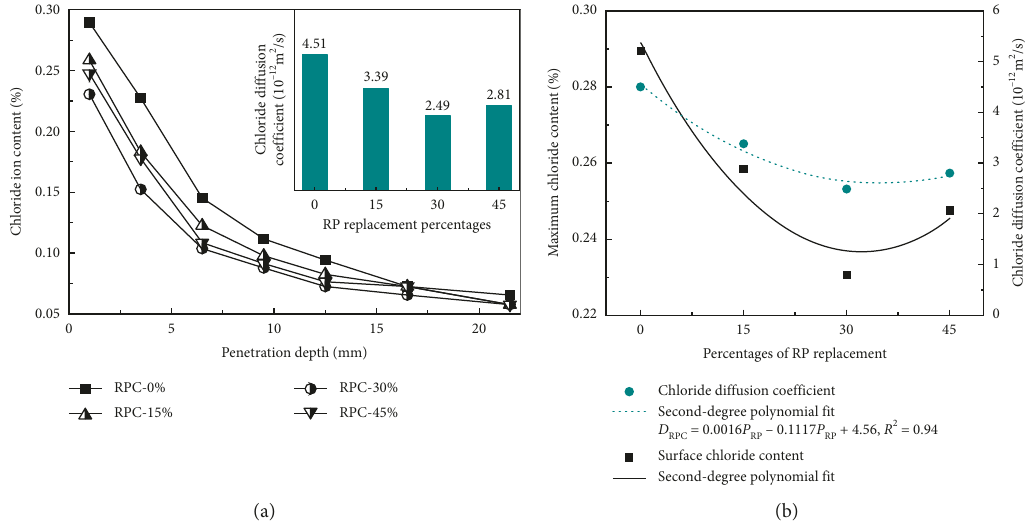
Figure 6: The chloride diffusivity of RPC without preloading damage. (a) The chloride content curves of RPC. (b) The correlation between the chloride diffusivity and RP replacement ratios.